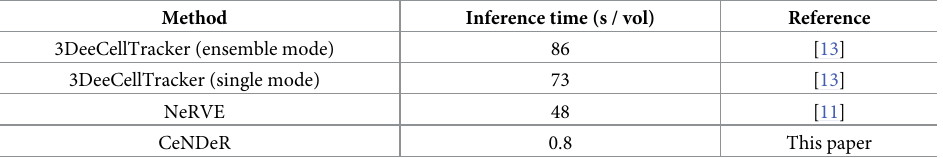
Table 6. Pipeline speed comparison. We compare the speed of CeNDeR pipeline with other methods, which must tackle both detection and tracking tasks. “s/vol” refers to seconds per volume.